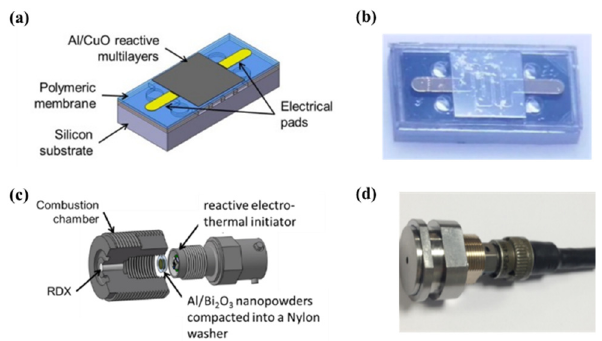
Figure 4. ( a ) Schematic and ( b ) photo of the reactive electro-thermal initiator on Epoxy / PET membrane. Chip dimension is 4 mm × 2 mm. ( c ) Schematic and ( d ) photo of one miniature detonator integrating Al / CuO multilayers as the initiator.